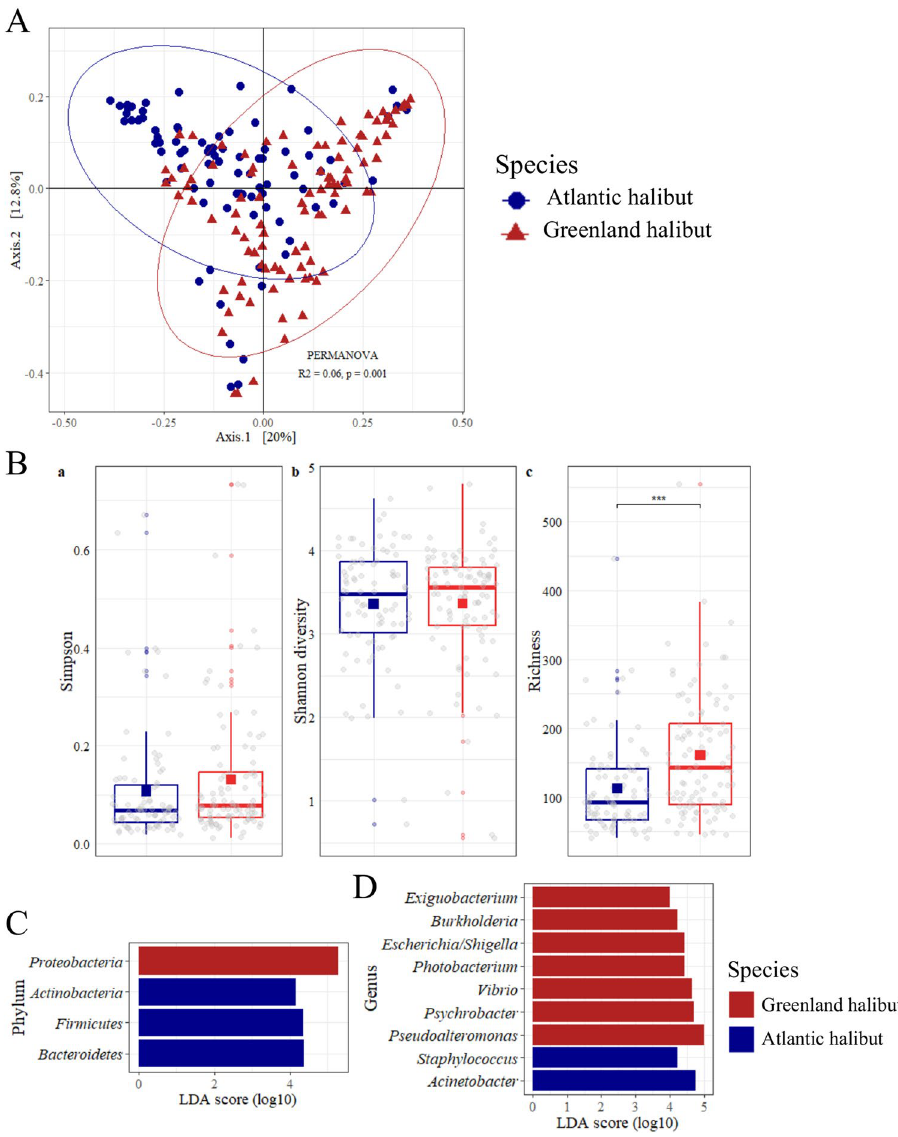
Figure 4. Biodiversity analysis. ( A ) PCoA plot of the β-diversity of the blood microbiome based on weighted UniFrac distances. ( B ) α-Diversity metrics for the cmDNA of Atlantic halibut (blue) and Greenland halibut (red). ***: p < 0.001. ( C and D ). Discriminative taxa at the phylum and genus levels in the cmDNA of both halibut populations ( p < 0.05). Atlantic halibut, n = 86, Greenland halibut, n =